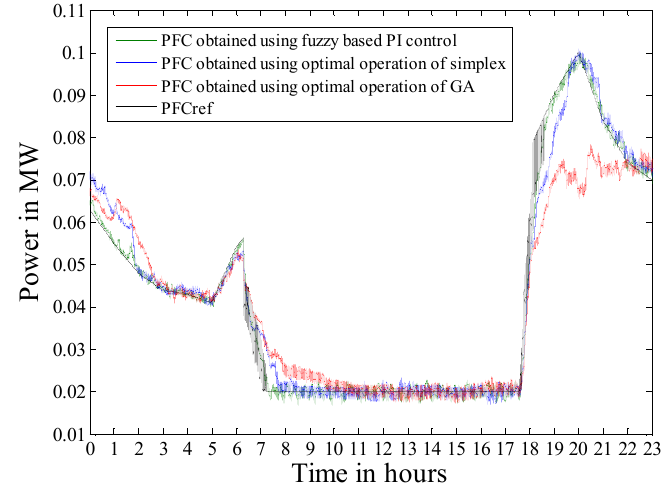
Figure 12. Comparison of SOFC power dispatch ( P FC ) matching the reference ( P FCref ) for the controllers. The SOFC reference set point ( P FCref ) is dependent on the change in load and PV generation. With